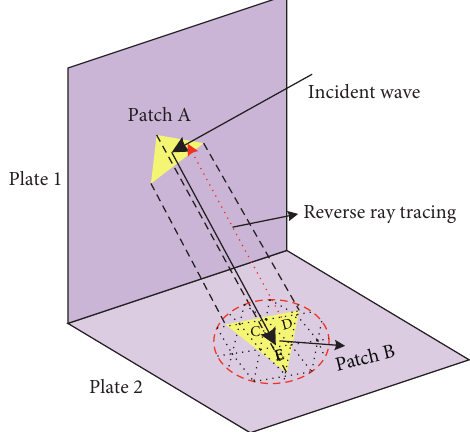
Figure 1: Illustration of bidirectional ray